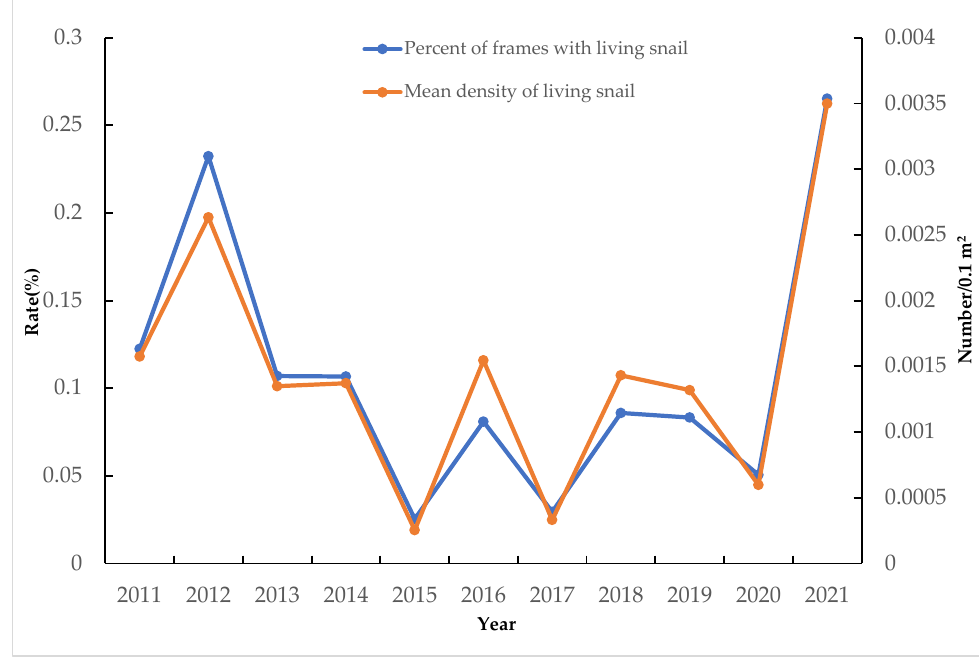
Figure 1. Distribution of Oncomelania hupensis in the outer lake of the wetland park. The 95%CI of the percent of frames with living snail:[0.056710589321 ， 0.159512460822], and the 95%CI of the